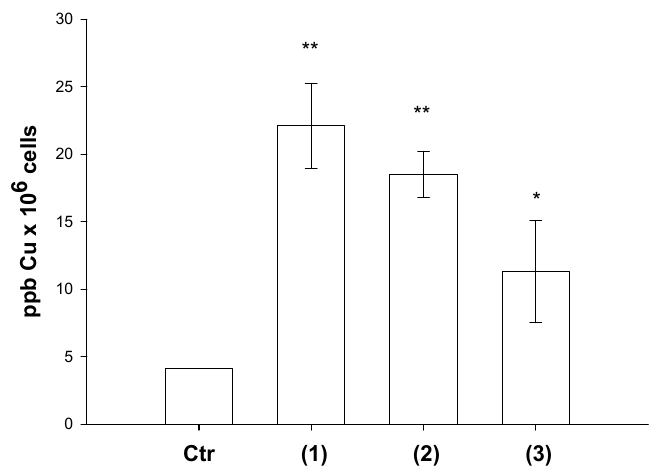
Figure 4. Intracellular copper content after treatment with compounds 1 – 3 . LoVo cells were treated for 24 h with 2 μ M of copper complexes, and intracellular copper amount was estimated by GF-AAS analysis. Error bars indicate the standard deviation. * P < 0.1, ** P < 0.01 compared with control.